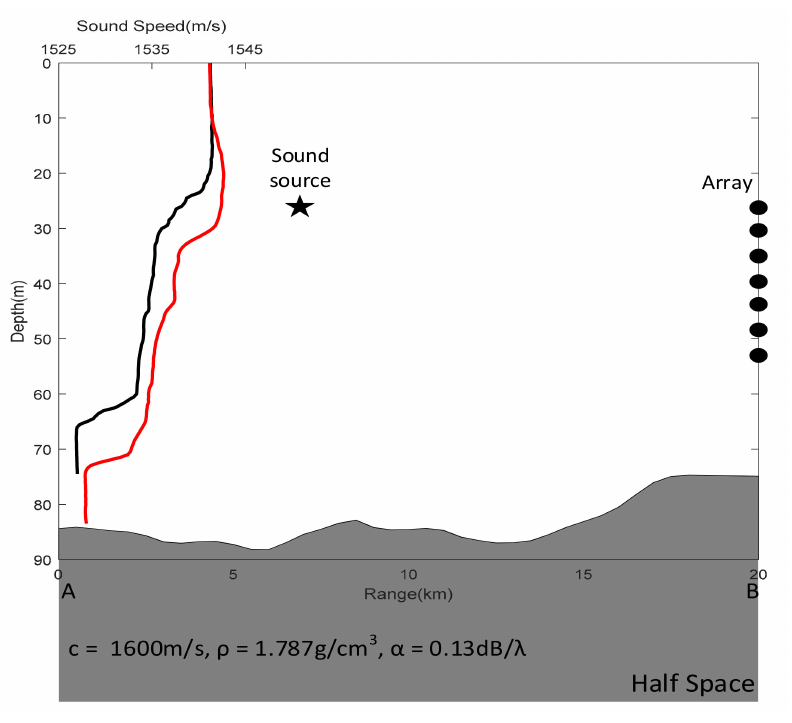
Figure 6. Waveguide parameters and source-receiver configuration using for simulation.